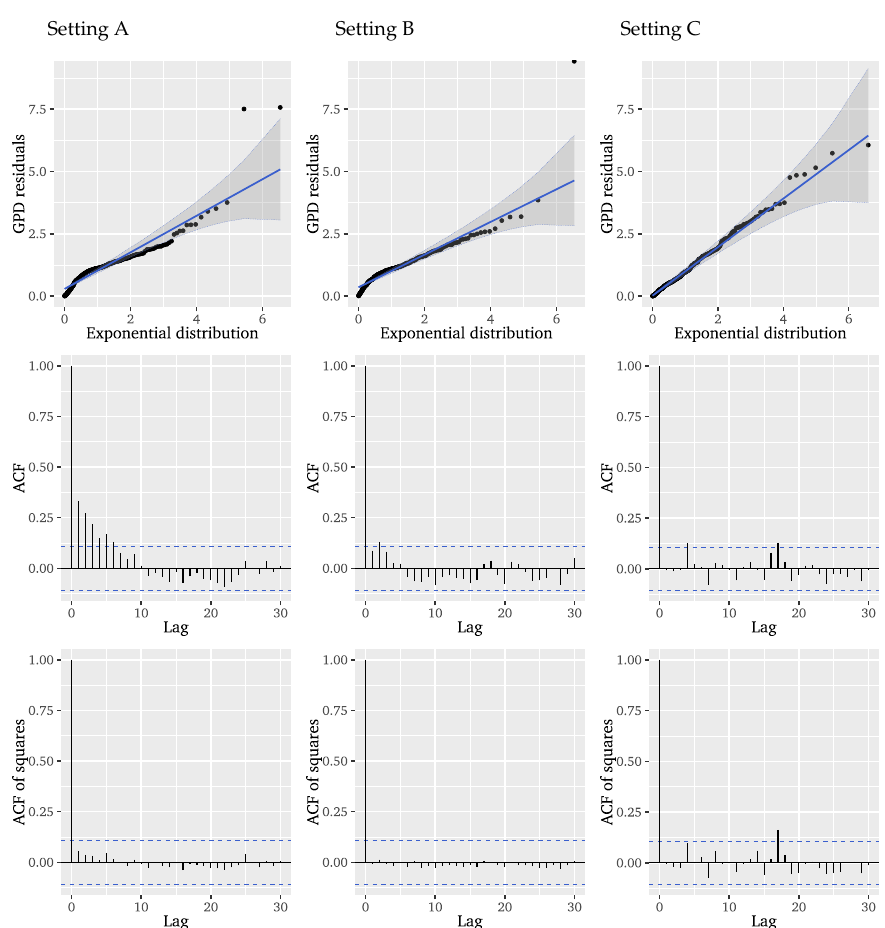
Figure 14. Unit exponential QQ plot and autocorrelation functions for the GPD residuals of the Hawkes-POT (with ETAS decay) for the simulated settings A, B and